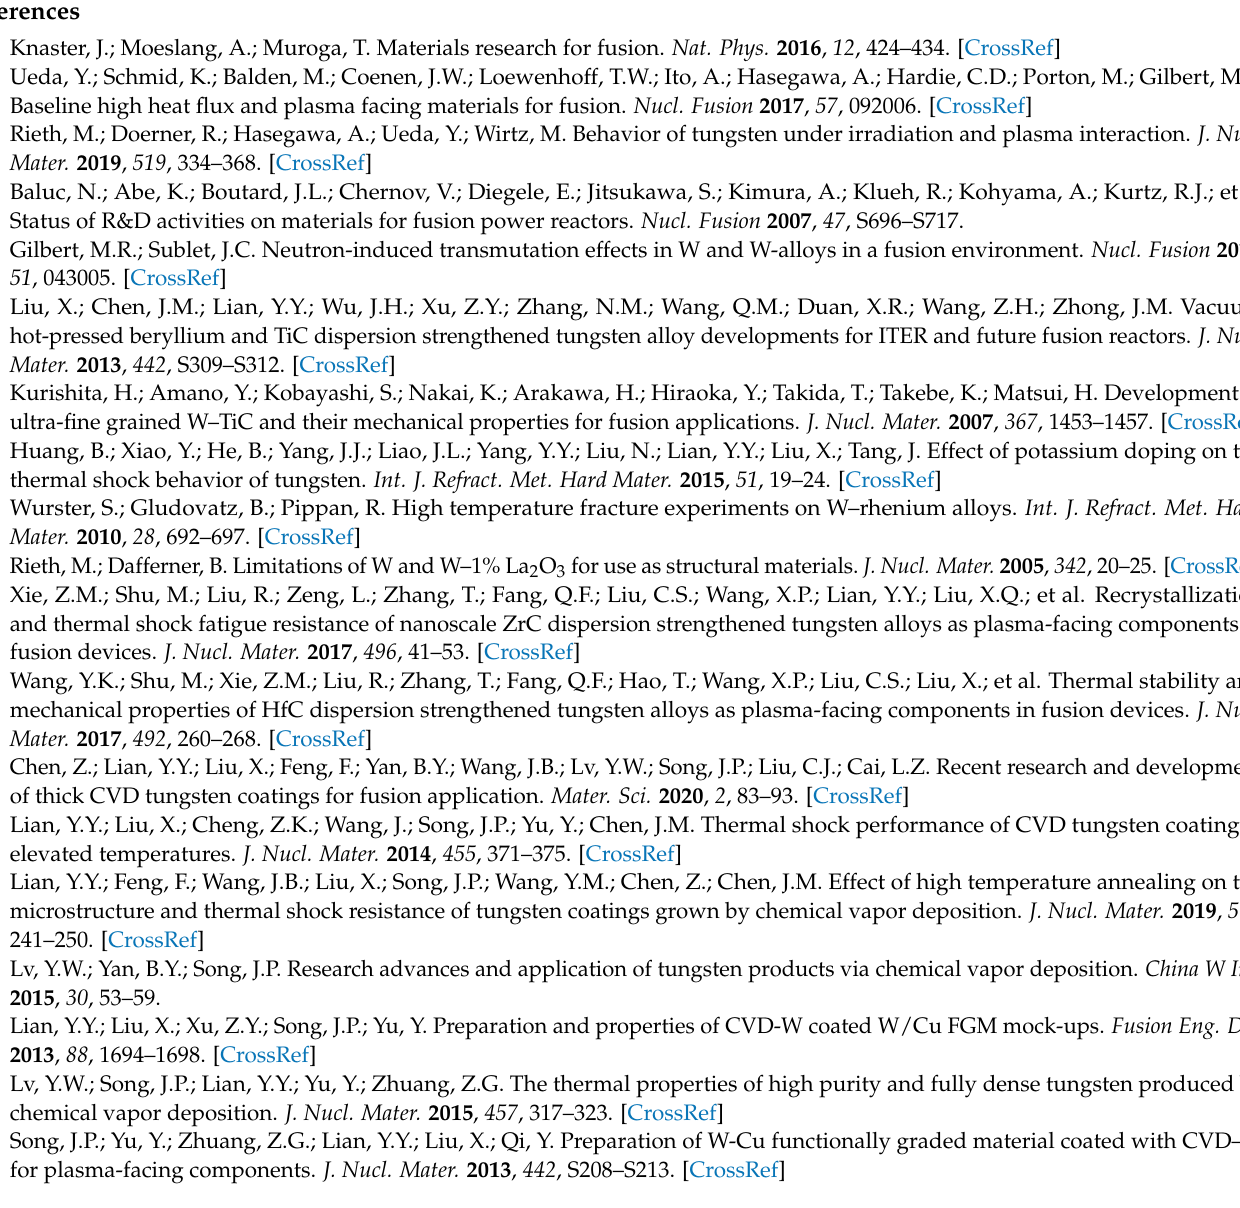
3. The surface morphology of the samples irradiated by the pure H neutral beam is different from that of the samples irradiated by the H + 6 at.% He neutral beam, which is probably caused by the different kinds of micro defects near the